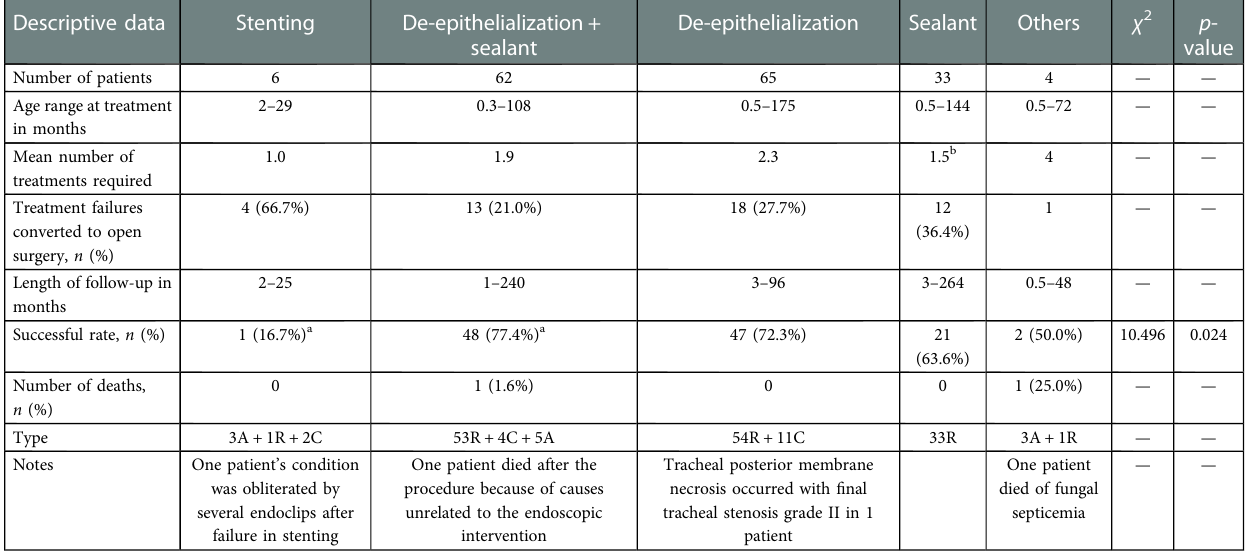
TABLE 1 Published outcomes of different endoscopic interventional techniques for TEF. Descriptive data